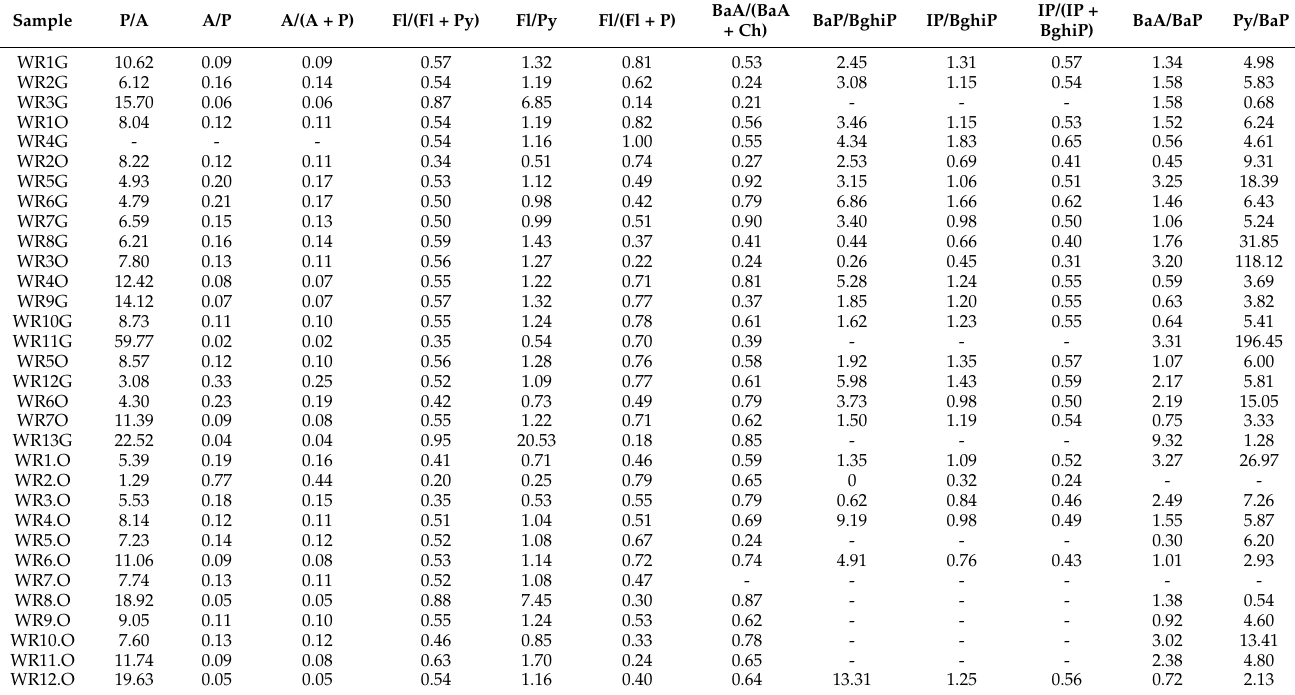
Table 3. Values of diagnostic PAH ratios in the Trzebinia